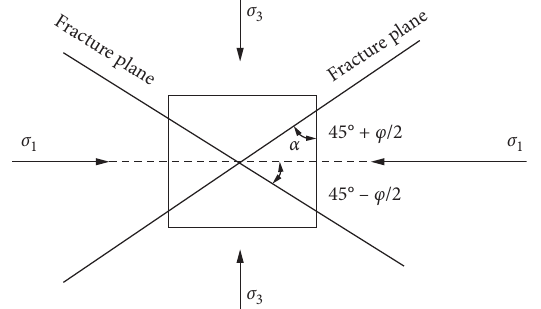
Figure 15: Diagram of fracture angle of the red sandstone samples.